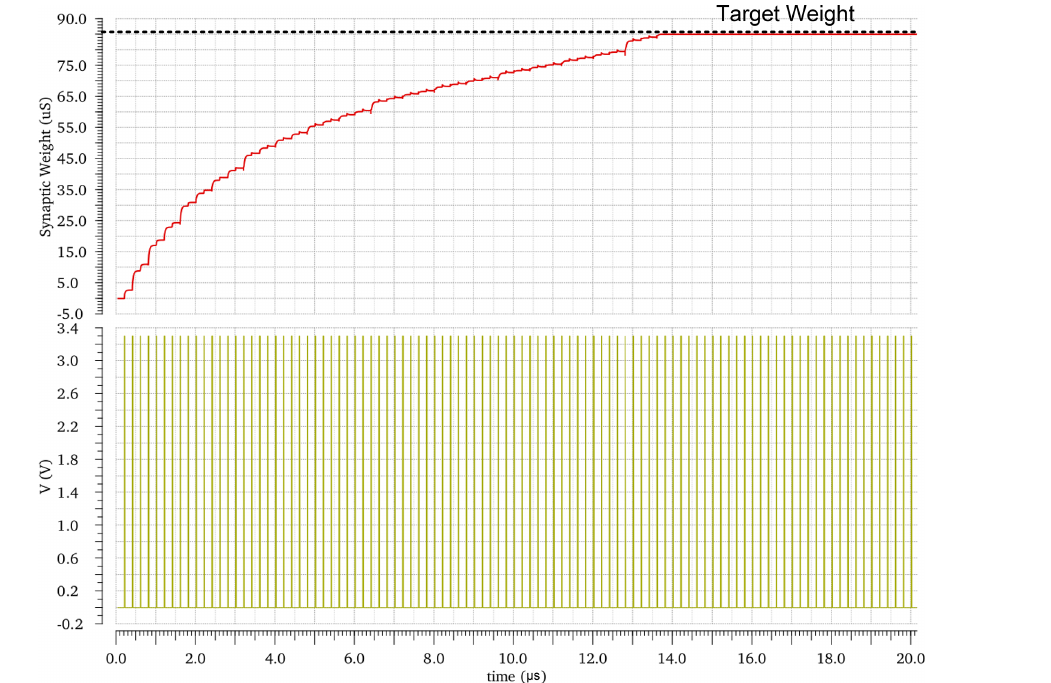
Figure 8. This figure shows the adaptation work of the first layer. The weight of the first synapse of the first ACD is adapted until it reaches the target weight. The variables V LEAK , V RFR , vg1, and vg2 of the second layer are fixed to 700mV, 800mV, 1.8V, and 220mV, respectively. Circuit conditions are V dd = 3 . 3V, and temperature is 27 ◦ C and on the nominal process. The value can be different, depending on the present perturbation of the regarded corner.